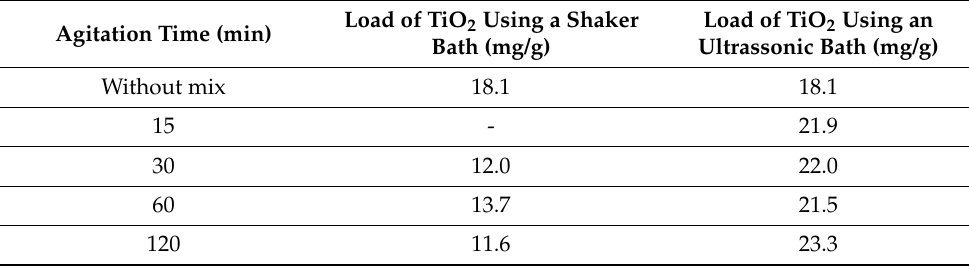
Table 1. Effect of contact time and type of agitation on the amount of TiO 2 impregnated. Agitation Time